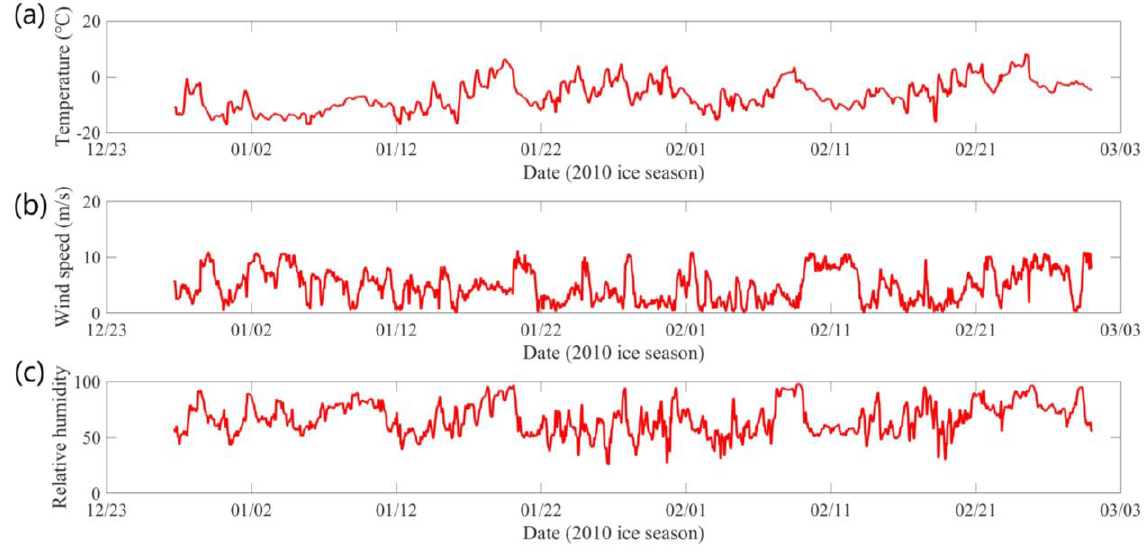
Figure 2. Time series (2009/2010) of ( a ) hourly measured air temperature, ( b ) hourly measured wind speed, ( c ) hourly measured humidity.